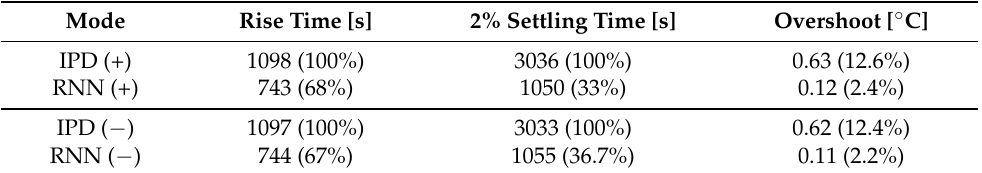
Table 2. Response characteristics comparison between the proposed RNN-based control method and the conventional method for both rising and falling processes. The overshoot values represent the maximum offsets of the temperature variations in rising and falling processes, which are denoted by the symbols (+) and ( − ) ,